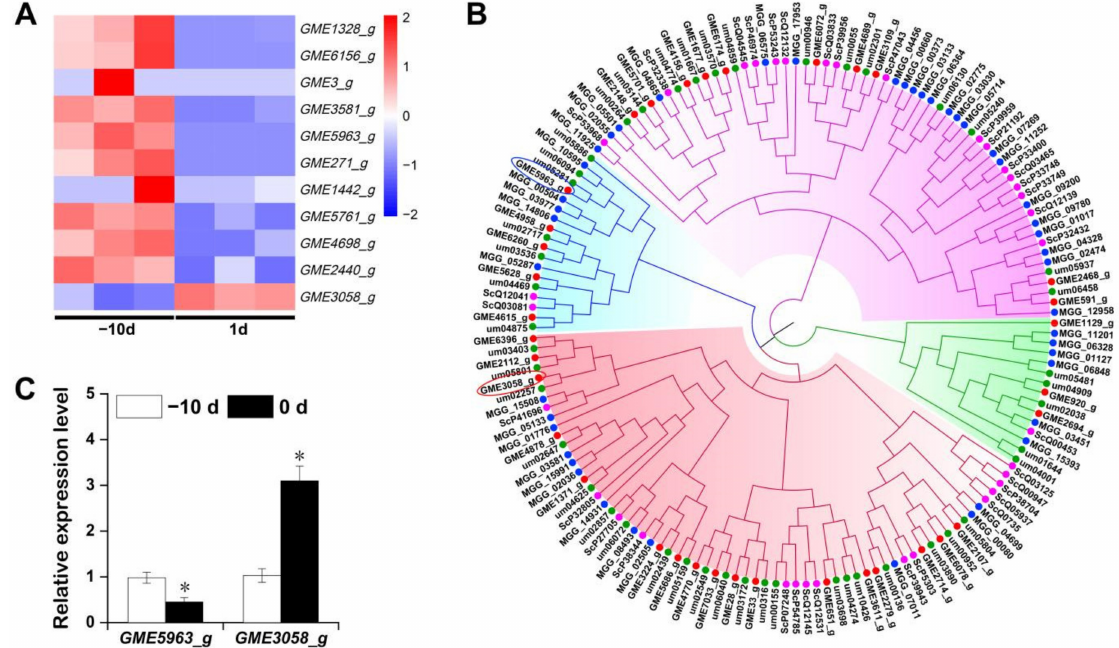
Figure 9. Analysis of C2H2 zinc finger proteins of U. esculenta . ( A ) Heatmap analysis of C2H2 DEGs in RNA-Seq at the early stage of stem-gall formation. ( B ) Phylogenetic analysis of the C2H2 zinc finger proteins in U. esculenta (red), U. maydis (green), M. oryzae (blue) and S. cerevisiae (amaranth). red circle: GME3058, blue circle: GME5963_g. ( C ) Validation of GME3058_g and GME5963_g expression levels in RNA-Seq data using RT-PCR. Asterisks (*) indicate significant differences ( p < 0.05) between same gene in the different stage of stem-gall